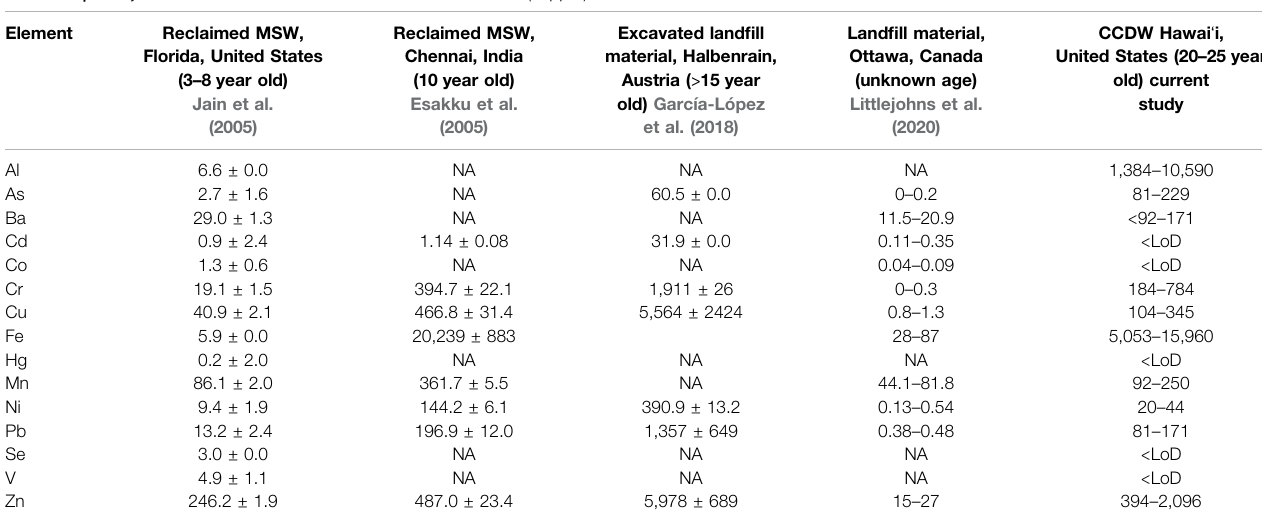
TABLE 5 | Heavy metal contents in other MSW and land fi ll materials (in ppm).